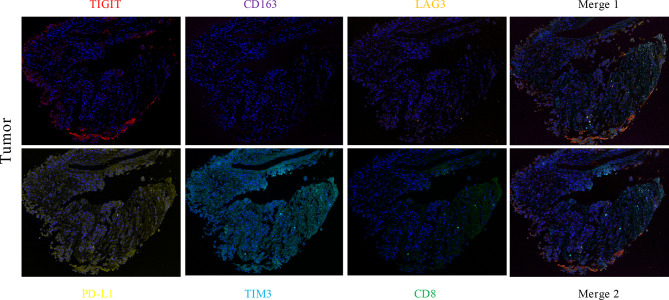
The expression levels of CD8 (green), TIM3 (light blue), PD-L1 (yellow), LAG3 (orange), CD163 (purple), and TIGIT (red) in lung CCS were detected by multiple immunofluorescence assays. The number of positive cells was estimated as follows: TIGIT ≥1%, other indexes <1%. CD8 and TIM3 colocalized, and there was no colocalization with other indexes.